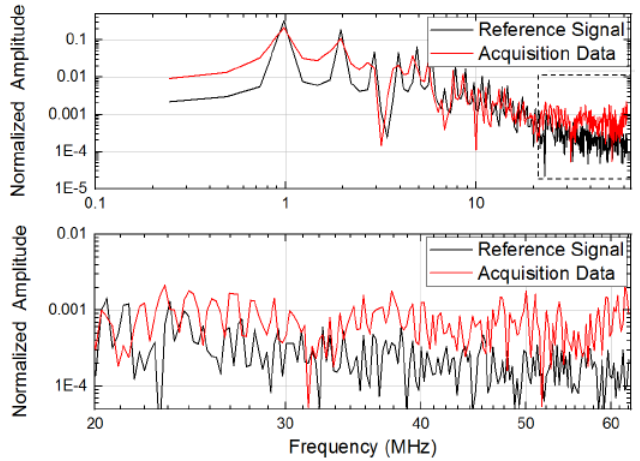
Fig. 4. Amplitude spectrogram comparison of acquired data and reference signal. Fig. 2. Architectural block of whole system.